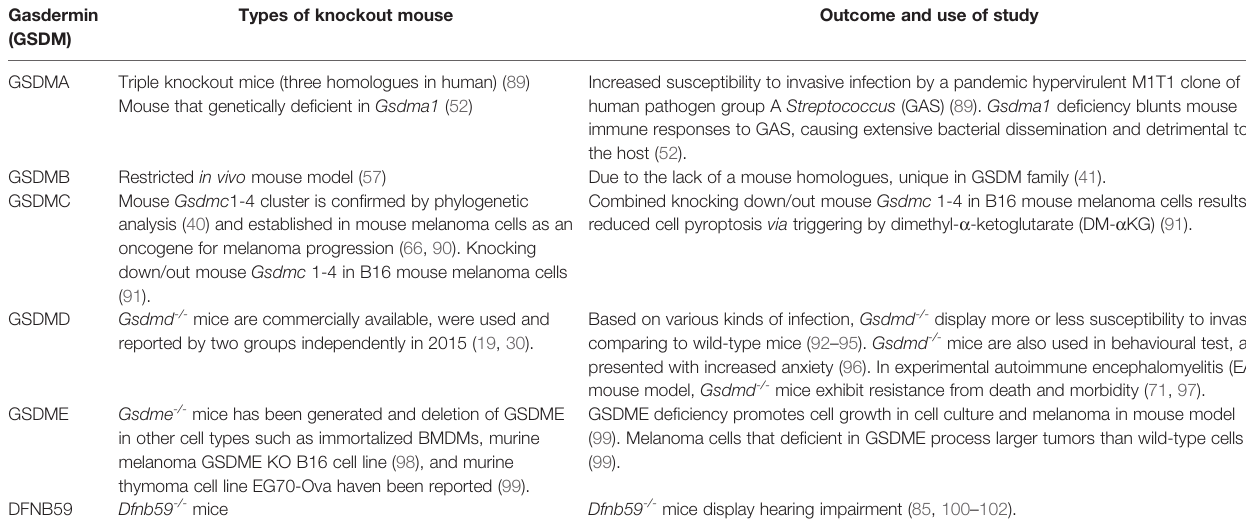
TABLE 2 | Available experimental knockout mouse in gasdermin family members.